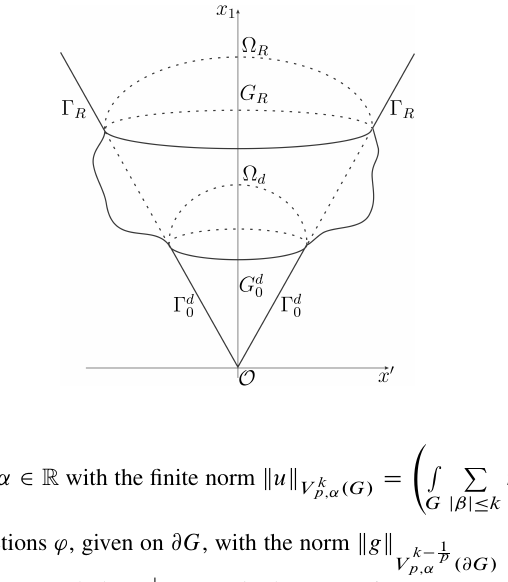
Fig. 1. an unbounded cone-like